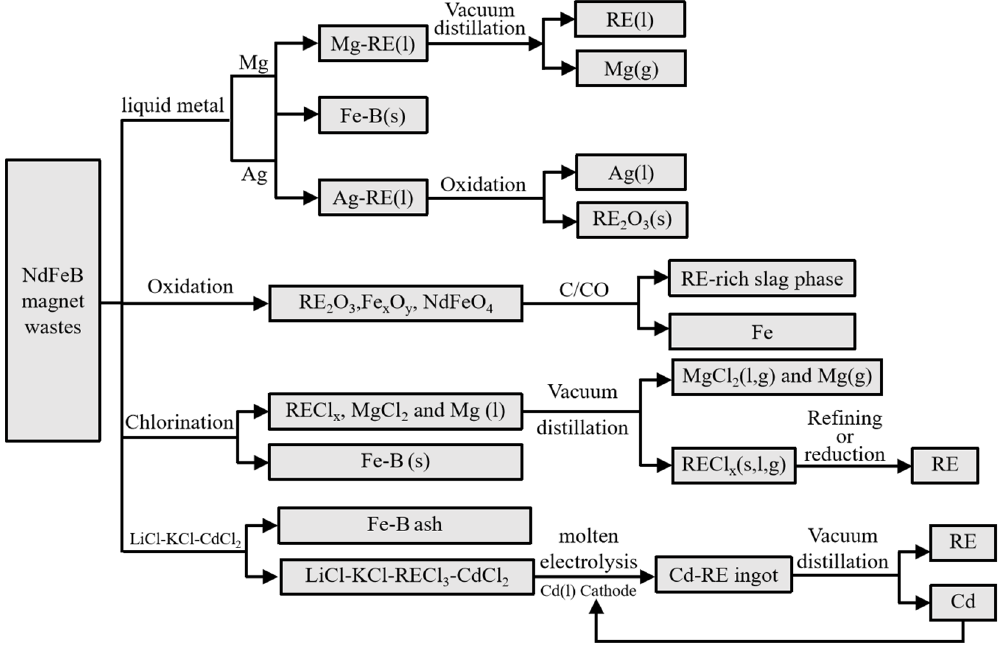
Figure 7. Flow chart of typical techniques for pyrometallurgy of NdFeB magnet wastes. Stopic et al. [118] proposed a pyrometallurgical recovery method whose main objec-